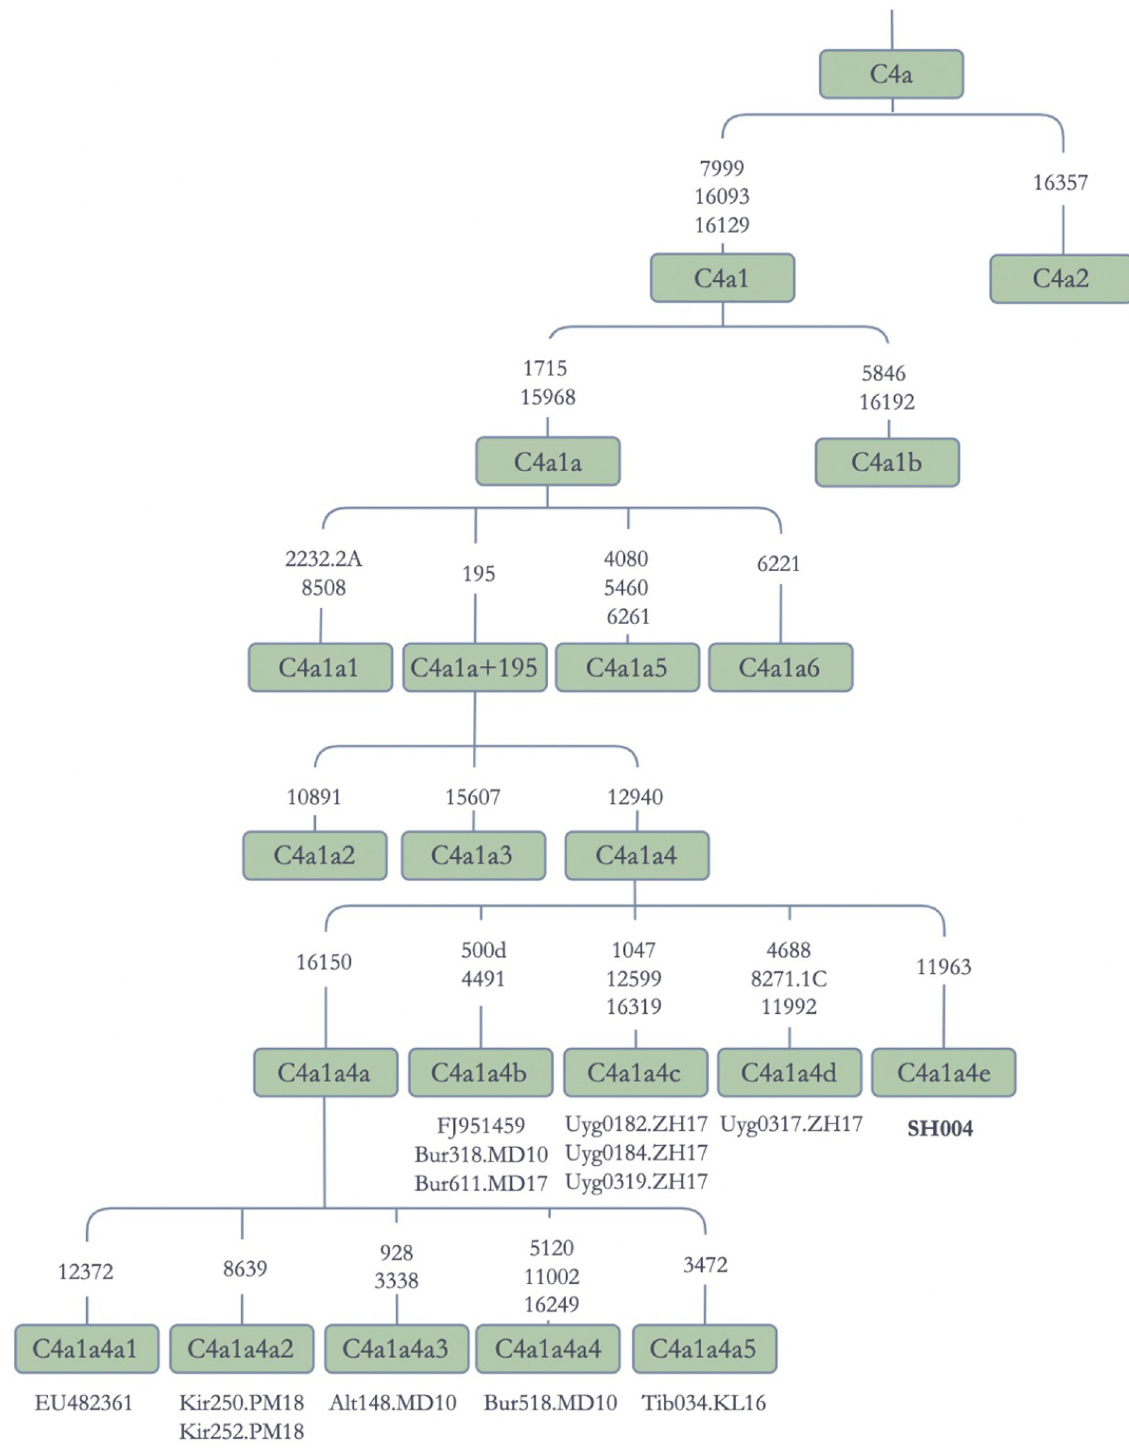
Fig 7. Schematic phylogenetic tree for the haplogroup C4a1 mitochondrial genomes. Note: Alt: Altaian; Bur: Buryat; Uyg: Uyghur; Kir: Kirghiz; Tib: Tibetan.